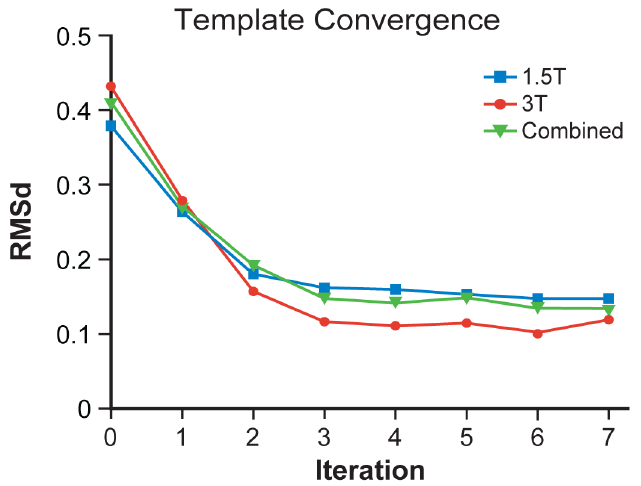
Figure 6. Template convergence. The RMSd between each average head template across successive iterations for generating the average head template. The RMSd exponentially decreased as the iterative averaging process proceeded. Convergence of the average head templates was reached by the fourth iteration.